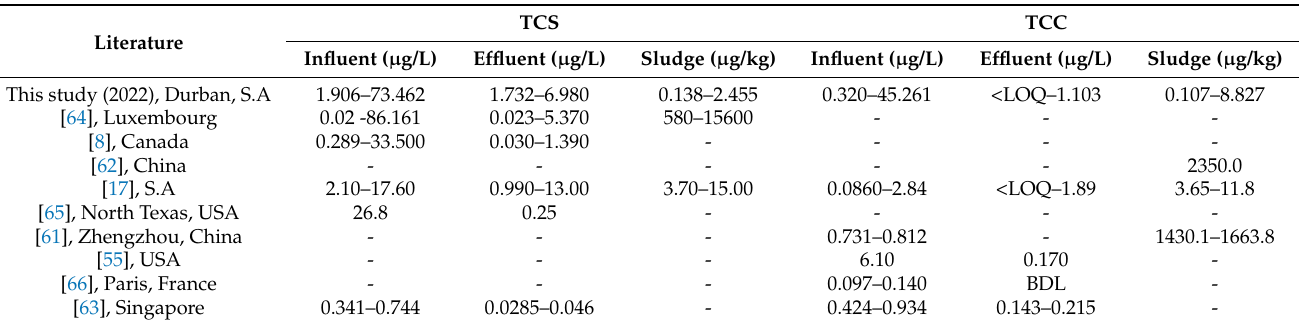
Figure 4. Distribution of TCS and TCC in wastewater sludge. (SS 1, sludge sample at Isipingo WWTP; SS 2, sludge sample at Southern WWTP; SS 3, sludge sample at New Germany WWTP; SS 4, sludge sample at Northern WWTP). Table 2. Concentration of TCS and TCC in wastewater influent, effluent, and sludge samples reported across the